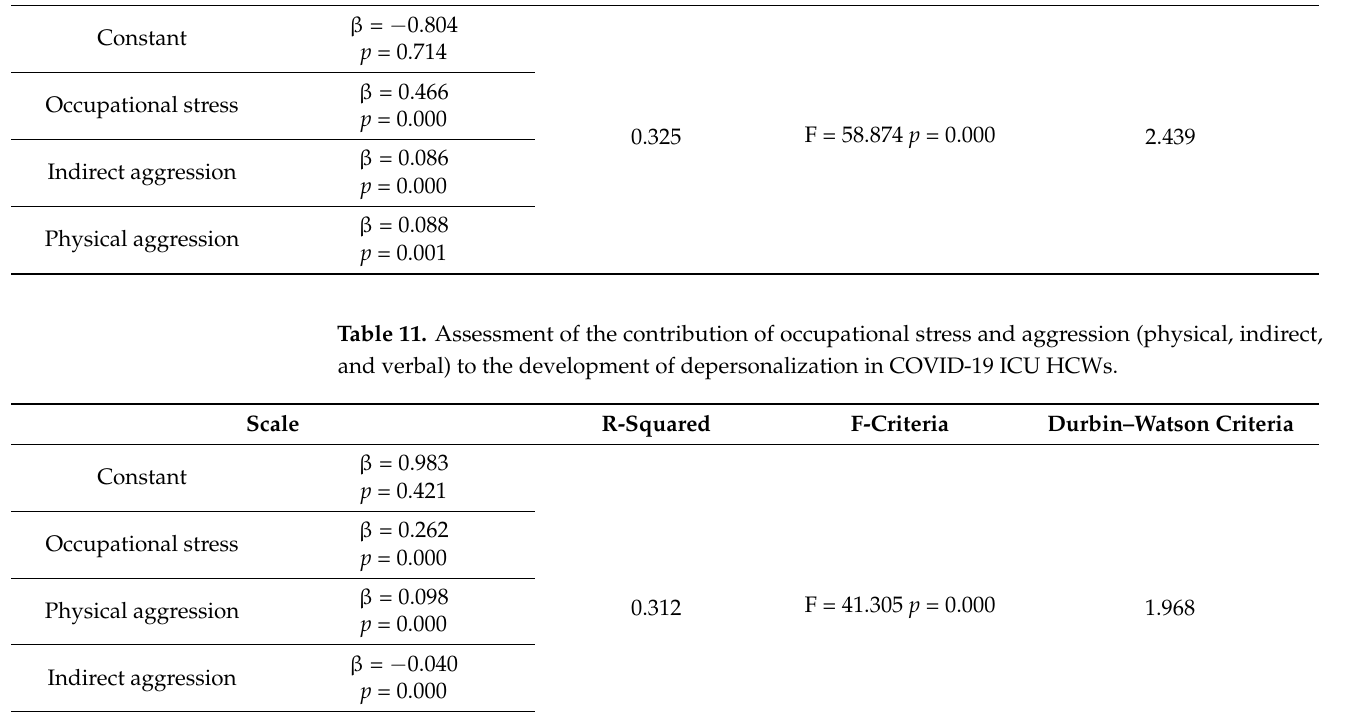
Durbin–Watson Criteria